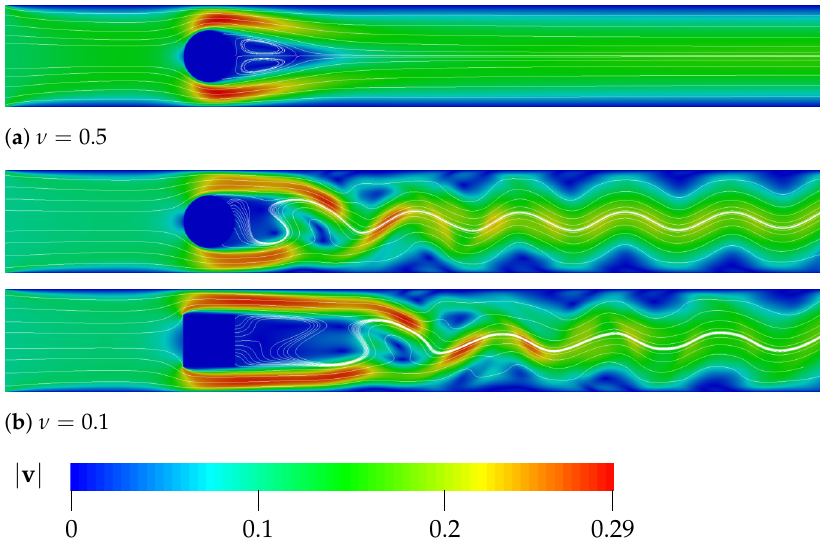
Figure 4. Velocity magnitude | v | and streamlines (white) after 10 6 time steps for flows past a cylinder at different viscosities ν . The picture on the top shows a separation bubble comprising two symmetric and counter-rotating recirculation zones. Other images contain unsteady Kármán vortex street patterns. At the inlet, constant velocity is set to v x = 0.1. Mesh resolution is 4096 × 512 nodes, sphere diameter and square edge are equal to half of the channel